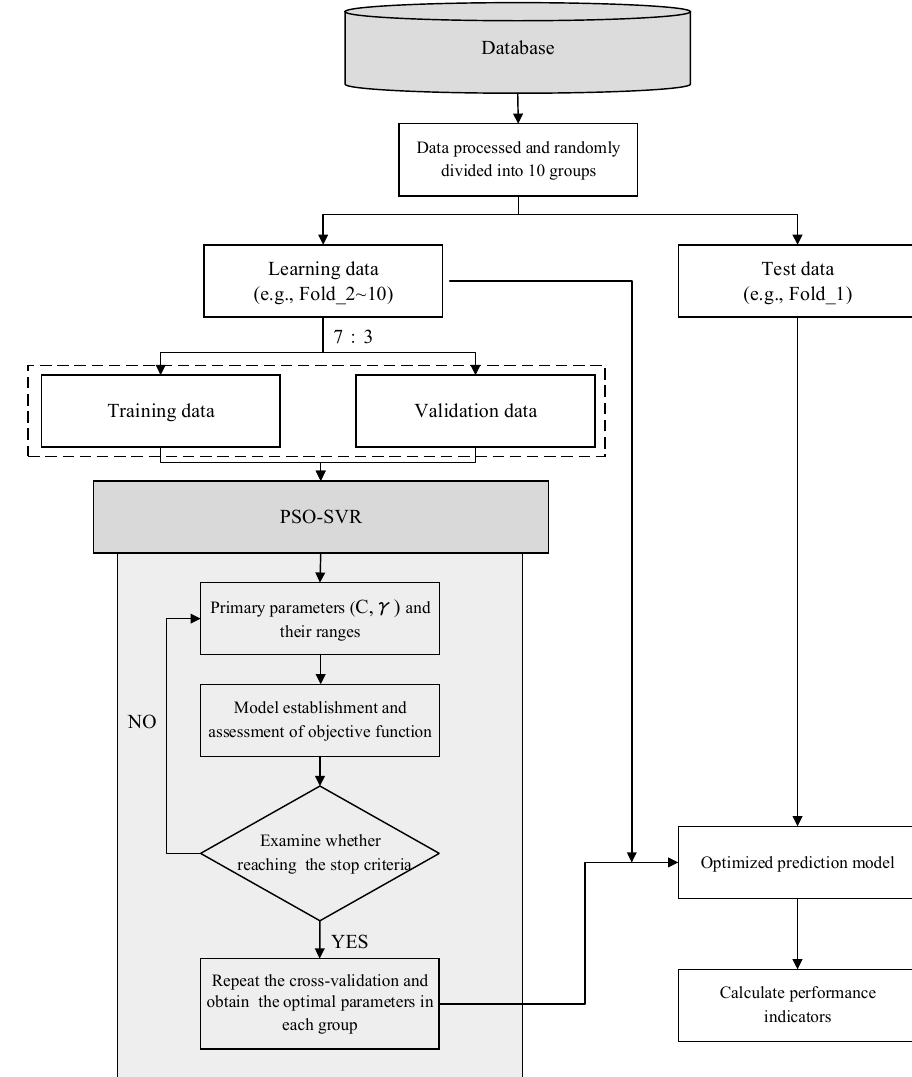
Figure 2. Framework for the development of the optimized model. Table 5. Model stability test after parameter optimization using PSO.